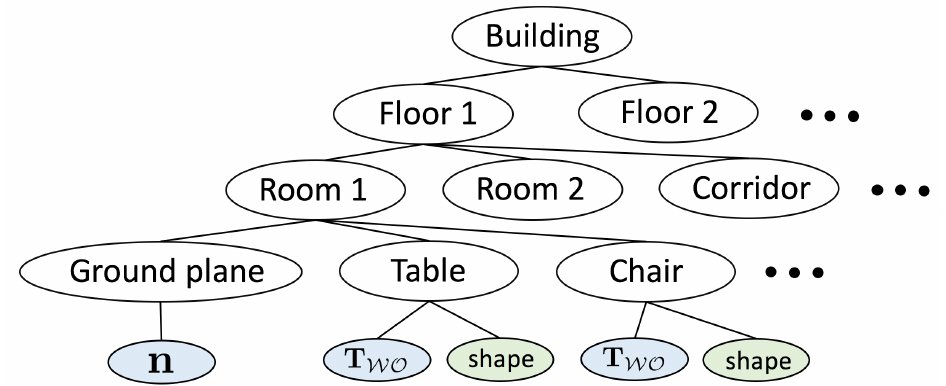
Figure 4. Example hierarchical, tree-based structure of man-made indoor